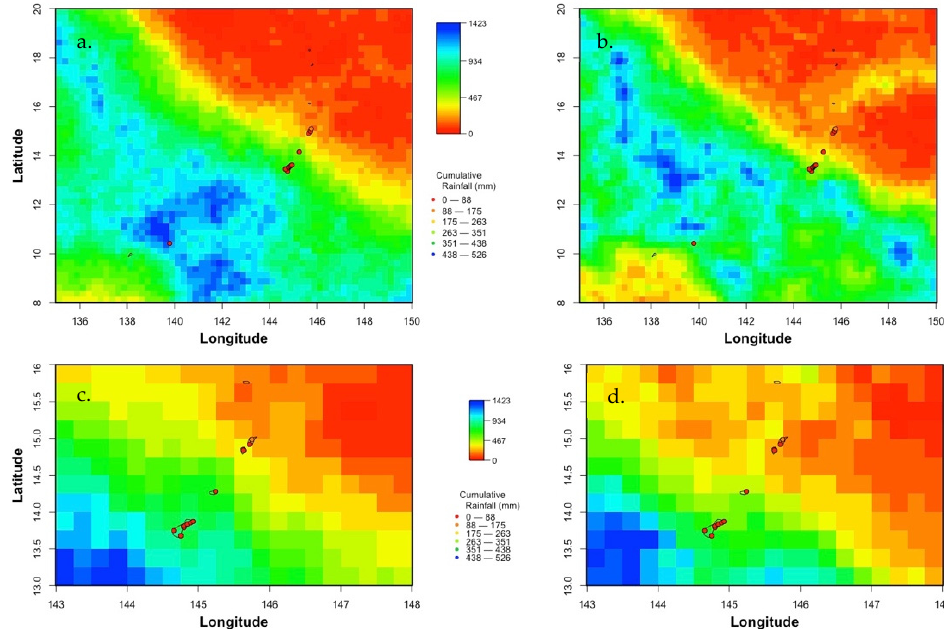
Figure 9. Cumulative rainfall values from PERSIANN ( a , c ) and TRMM ( b , d ) at two different spatial scales during the 2002 Typhoon Chataan. Table 5. R-squared values for daily cumulative rainfall estimates during the 2002 Typhoon Chataan for PERSIANN and TRMM TMPA.